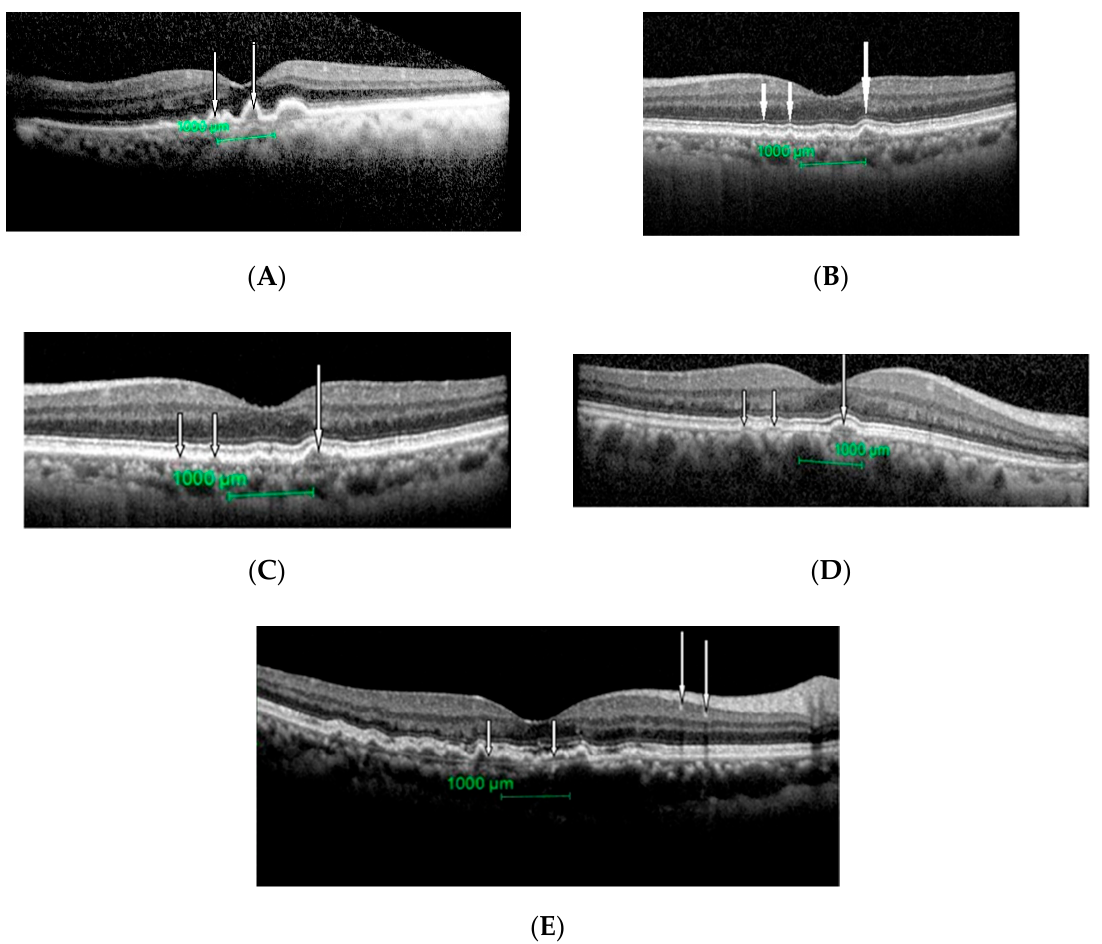
Figure 2. Di ff erent size and texture of drusens seen in patients with intermediate ARMD. ( A ): Drusen can be seen as dome-like elevation of the retinal pigment epithelium protruding into adjacent photoreceptor layers (white arrows). ( B ): Cluster of drusens (large arrows) around fovea with a hyper-reflective material (small arrow). ( C ): Few small (small arrows) and a large (large arrow) drusen. External limiting membrane and photoreceptor inner and outer segment junctions are intact here. ( D ): Few medium sizes (small arrows) and a large (large arrow) drusen. External limiting membrane and photoreceptor inner and outer segment junctions are intact here. ( E ): Extensive large drusens with hyper-reflective materials seen (white arrows).